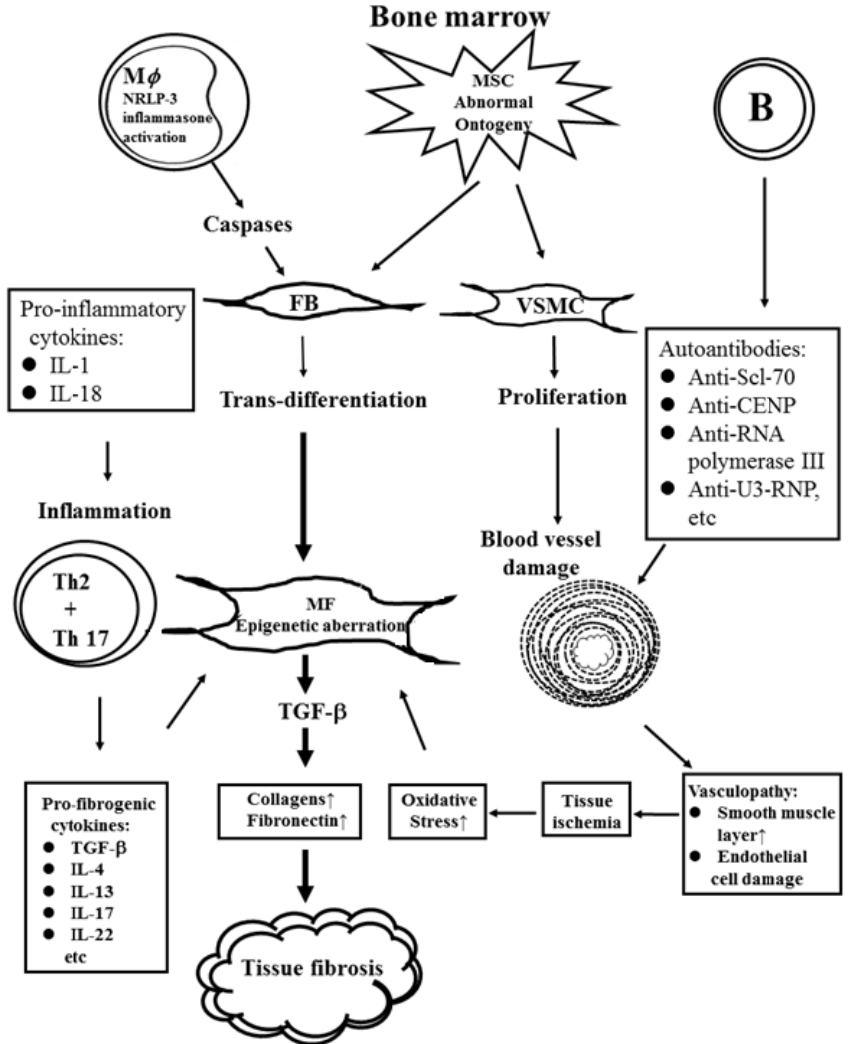
Figure 3. The underlying cellular and molecular bases of vasculopathy, chronic inflammation, and tissue fibrosis in patients with systemic sclerosis via pro-inflammatory cytokines, pro-fibrogenic cytokines, autoantibodies, caspases, and oxidative stresses to elicit trans-di ff erentiation of fibroblasts to myofibroblasts and finally tissue fibrosis in the patients. M ϕ : macrophage, MSC: bone marrow-derived mesenchymal stem cell, FB: fibroblast, MFB: myofibroblast, VSMC: vascular smooth muscle cell. 3.1.1. Aberrant Ontogenesis of Mesenchymal Stem Cells (MSCs) and Abnormal Cellular